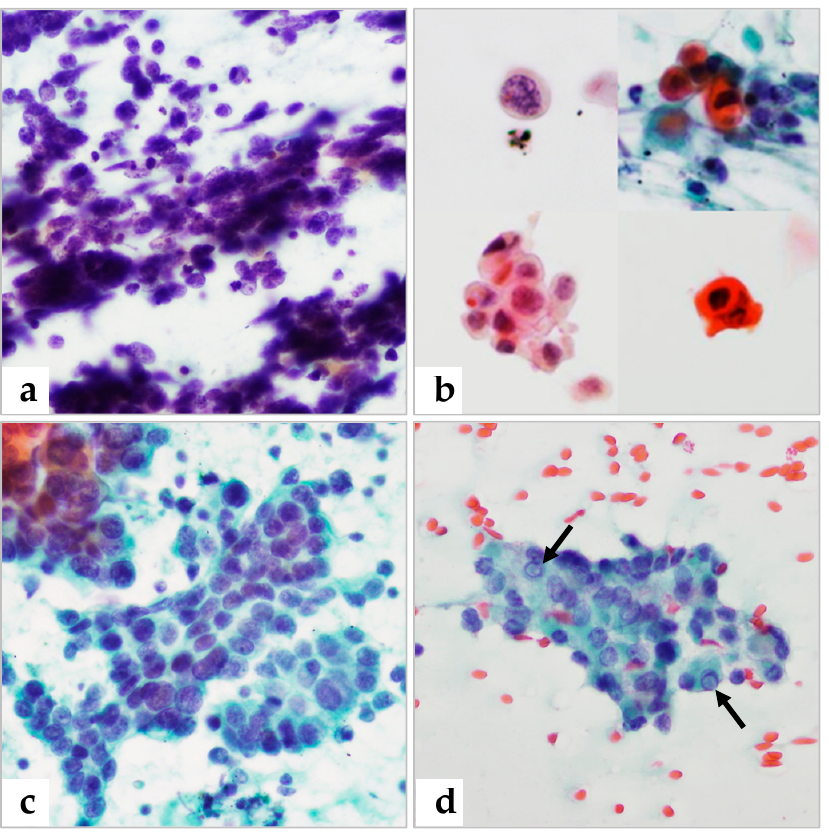
Figure 1. Presence of cancer cells on FNAC slides coupled with absence of tumor cells on biopsy slides due to tissue sampling errors. ( a ) A metastatic small cell carcinoma exhibiting a crush artifact and apoptosis of individual cells. ( b ) A metastatic keratinizing squamous cell carcinoma. Nuclei are hyperchromatic with irregular membranes or pyknotic with dense orangeophilic cytoplasm (composite figure of four different areas). ( c ) Syncytial tissue fragments of adenocarcinoma cells. ( d ) Metastatic papillary thyroid carcinoma showing intranuclear cytoplasmic inclusions (arrows). ( a – d ): Papanicolaou stain, 400× magnification. Table 5. Cytologic diagnoses of tissue sampling error cases .